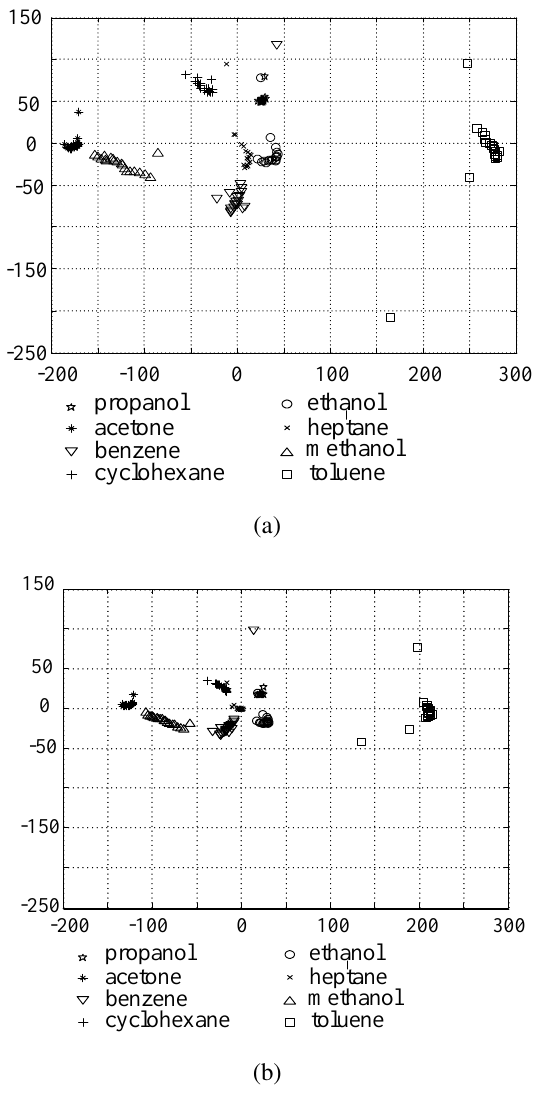
Figure 7. Distribution of the original data and refined data in PCA feature space. (a) Original data; (b) Refined data.